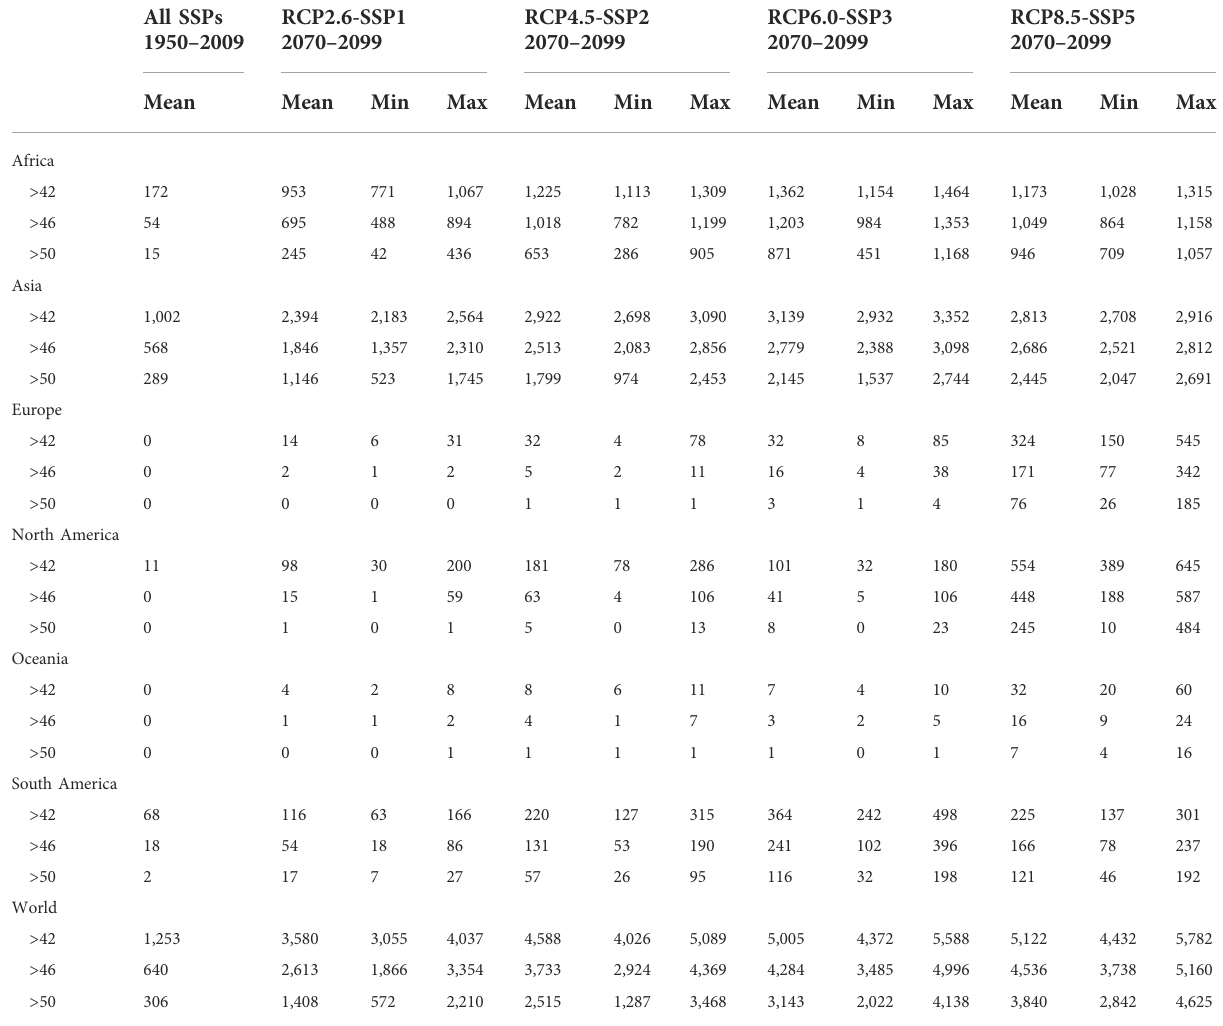
TABLE 4 Total urban population exposed to extreme heatwaves by region. This table presents the mean and range of total projected urban residents exposed to 15-day heatwaves of > 42 ° C. The data are presented by region and for the